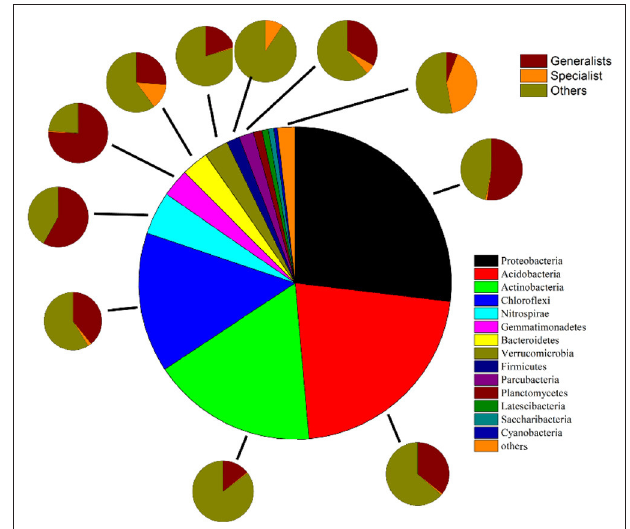
FIGURE 4 | Phylum compositions of all taxa, specialists, generalists and other taxa. The largest pie in the middle shows the phylum compositions of total bacteria. Sequences that are not classified or can be classified into known groups but have a mean relative abundance < 0.1% are assigned to “others.” The eleven smaller pies show the proportions of specialists, generalists and the remaining groups belonging to Proteobacteria, Acidobacteria, Actinobacteria, Chloroflexi, Nitrospirae, Gemmatimonadete, Bacteroidetes, Verrucomicrobia, Parcubacteria, Firmicutes, and